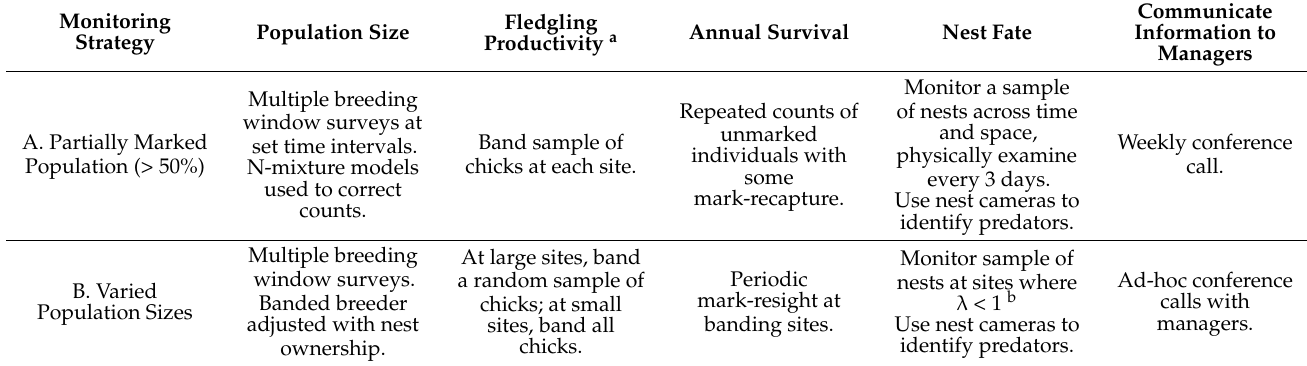
Table 2. Strategy table used to summarize nine potential monitoring strategies (A to I) and methods identified by the Western snowy plover technical team for analysis (also see Supplementary Materials 3 for detailed descriptions of each monitoring